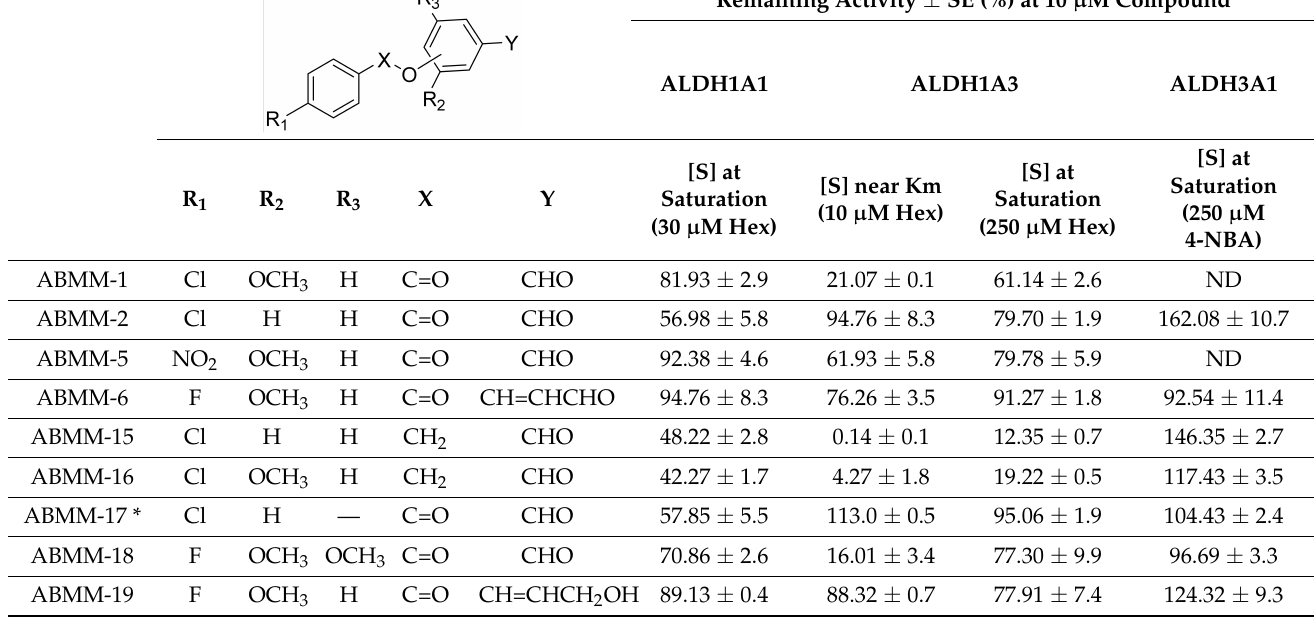
Table 1. Inhibition screening of the selected ABMM compounds against ALDH1A1, ALDH1A3 and ALDH3A1. Enzyme activity was measured with hexanal (ALDH1A1 and ALDH1A3) or 4-NBA (ALDH3A1). Experimental values are shown as the mean ± standard error (SE). ND: Not Determined.